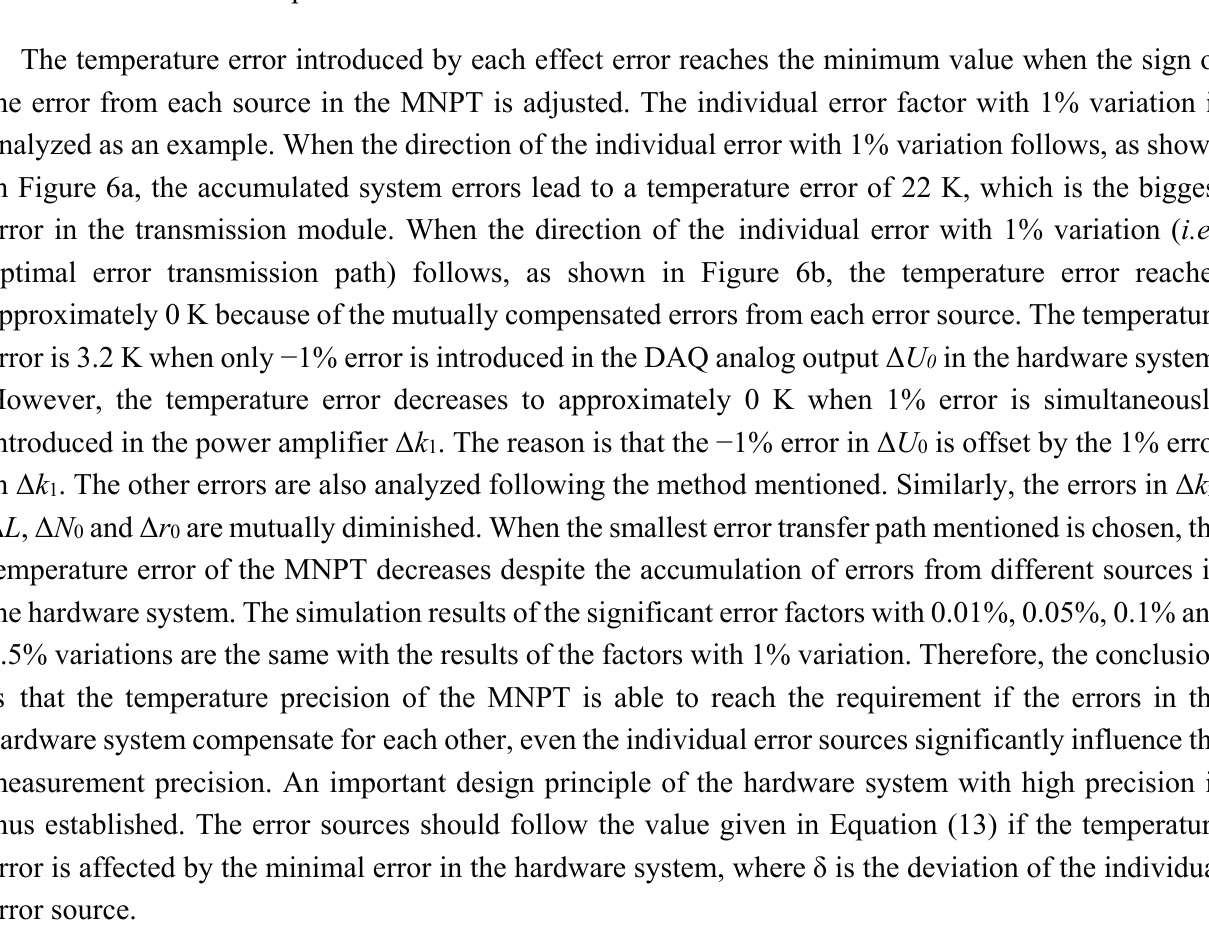
Figure 6. Maximum and minimum transmission direction of the temperature error caused by some factors, such as the radius of the Helmholtz coils ( r 0 = 0.1025 m), the turn of the Helmholtz coils ( N 0 = 168), the AC impedance of the Helmholtz coils ( ω = 44.06247 Ω ), the voltage gain of the power amplifier ( k 1 = 7.8), the attenuation coefficient of the power amplifier within the pass band ( k 2 = 1) and the signal source ( U 0 = 5.75 V). The deviation of each factor respectively is 0.01%, 0.05%, 0.1%, 0.5%, 1%. ( a ) represents the maximum transmission direction of the temperature error; ( b ) represents the minimum transmission direction of the temperature